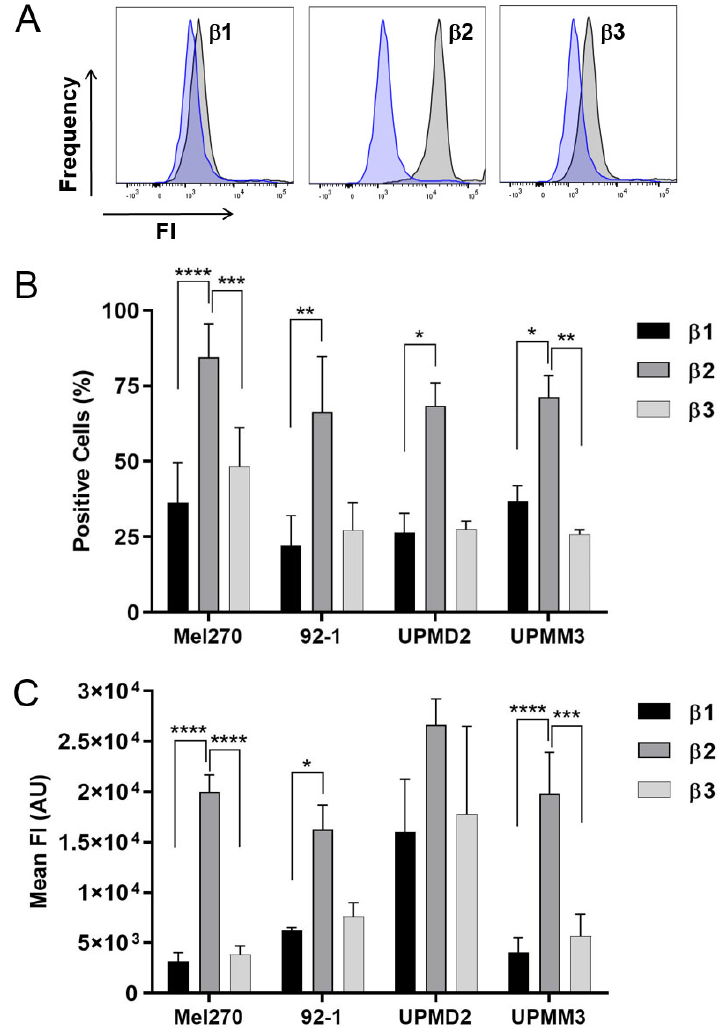
Figure 7. Presence of β -adrenergic receptors on the cell surface of UM cell lines. UM cell lines Mel270, 92-1, UPMD2, and UPMM3 were analyzed for the expression of β 1-, β 2-, or β 3-adrenergic receptors (ADRB1, ADRB2, ADRB3) by flow cytometry. ( A ) Representative histograms of Mel270 cells stained for isotype control (blue) and the respective β -adrenergic receptors (grey). ( B ) Analysis of the frequency of cells positive for the respective β -adrenergic receptor given in (%). ( C ) Analysis of mean fluorescence intensities (FI) of stained cells given in arbitrary units (AU). Data represent the mean ± SD of at least two independent experiments for each cell line. Statistical analysis with two-way ANOVA and Tukey’s multiple comparisons test, significance levels were indicated at p values: * < 0.05, ** < 0.01; *** < 0.001, **** < 0.0001.